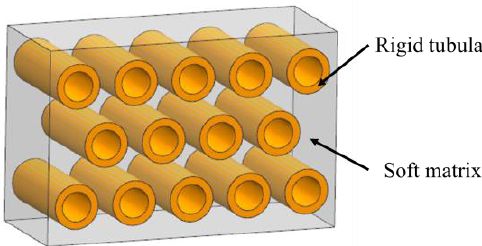
Figure 5. Schematic diagram of the tubular model.